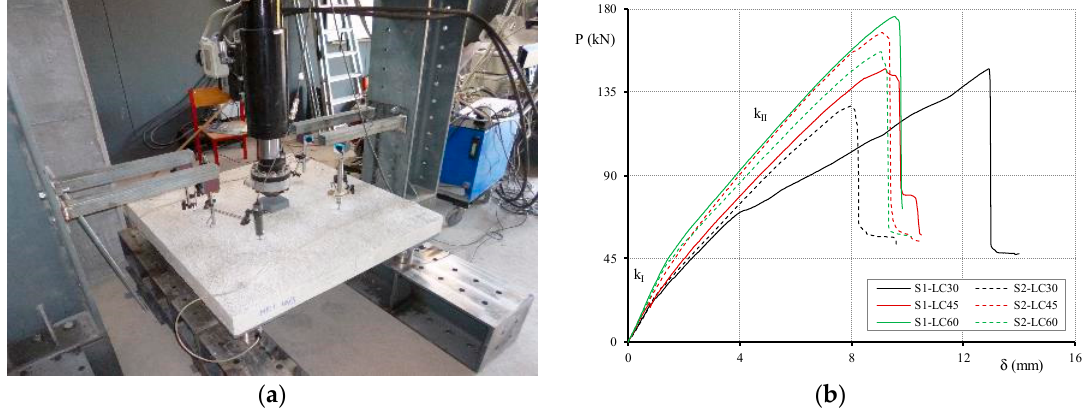
Figure 3. ( a ) General view of test set-up; ( b ) Curve load—displacement at the centre of the slab (P- δ ).